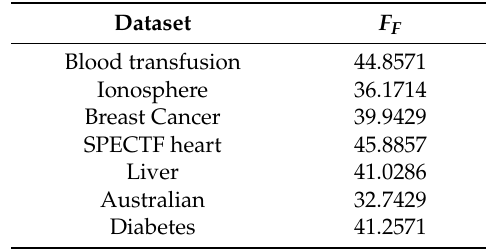
Table 3. F F values of the Friedman test among the accuracies for each dataset (significance level α =